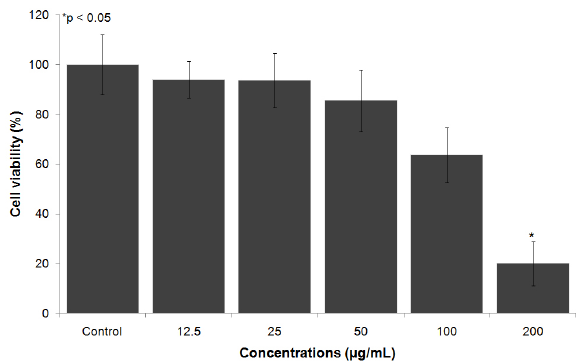
Figure 6. Cytotoxic effect of different concentrations (200-12.5 µg/mL) of B. leucurus venom on murine macrophages . The initial cell density was 1 x 10 6 cells/ mL. The graph presents mean ± SEM (n = 3). *p < 0.05 compared to the corresponding control group.